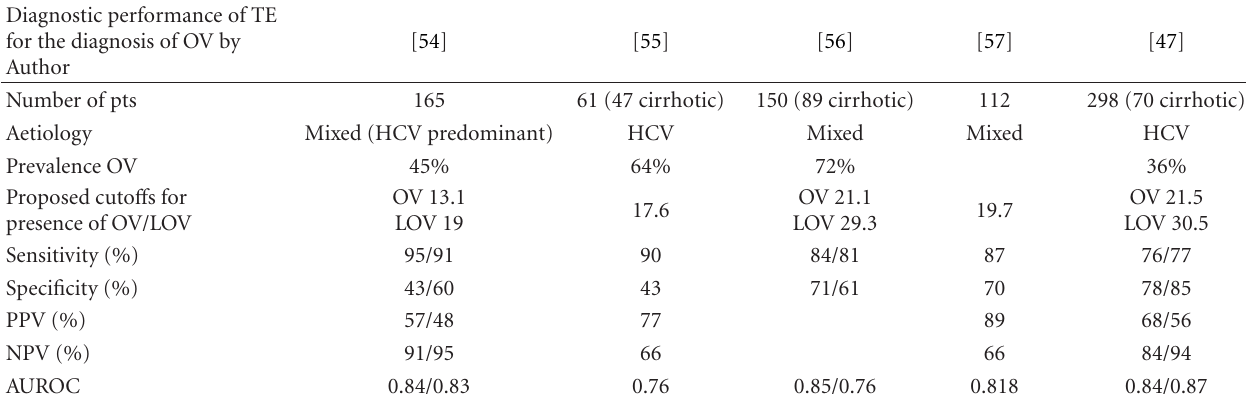
Table 1: Summary of diagnostic accuracy of LSM for the detection of oesophageal varices (OV) or large varices (LOV). TE: transient